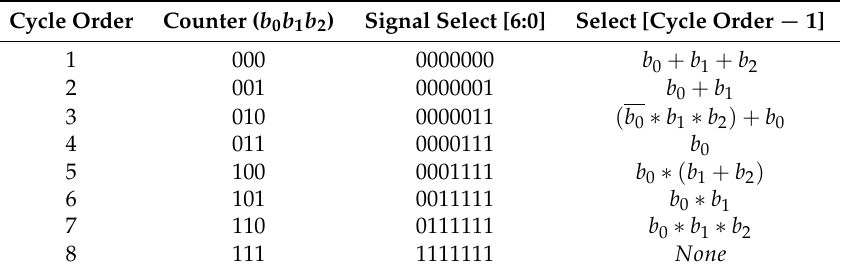
Table 1. Binary representation of the signals Counter and Select along with the cycle